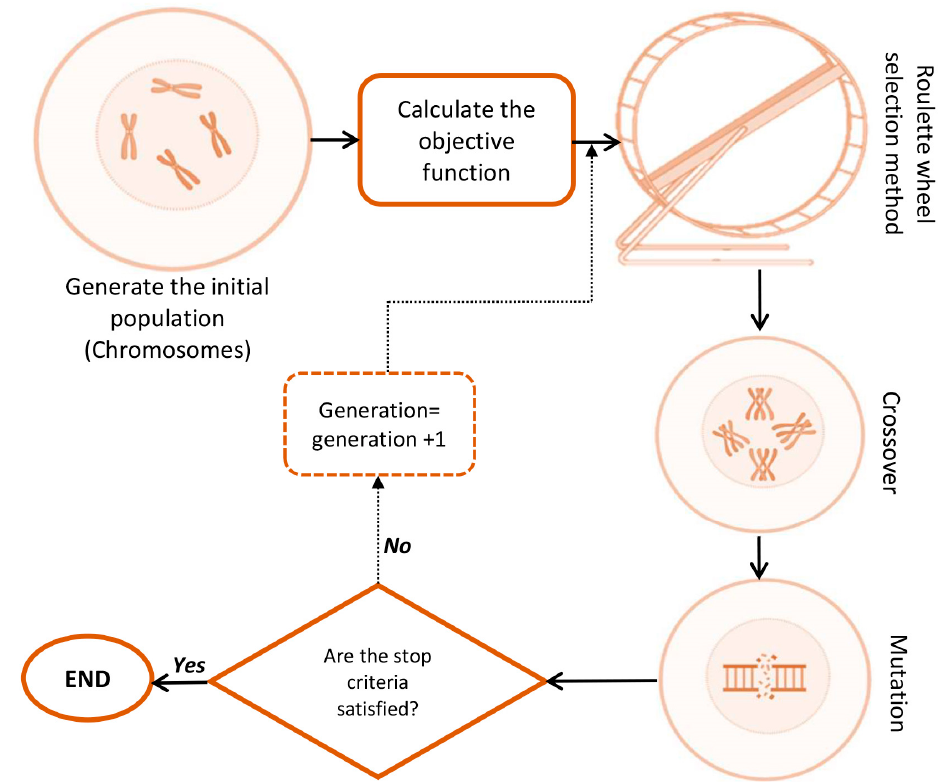
Figure 4. Schematic representation of genetic algorithm (GA).